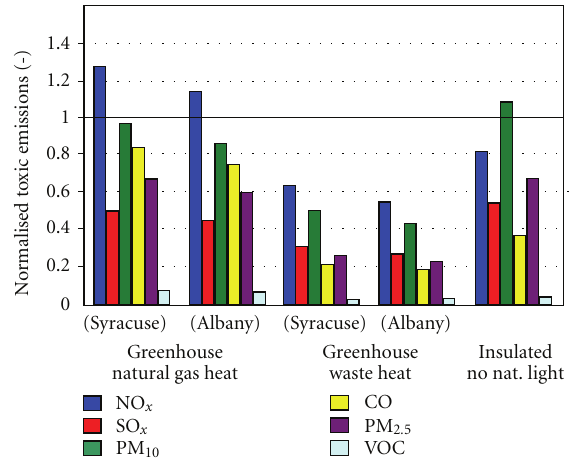
Figure 9: Toxic air emissions from microalgae biodiesel production—mass emissions normalized by dividing by the corresponding emissions for soy biodiesel for